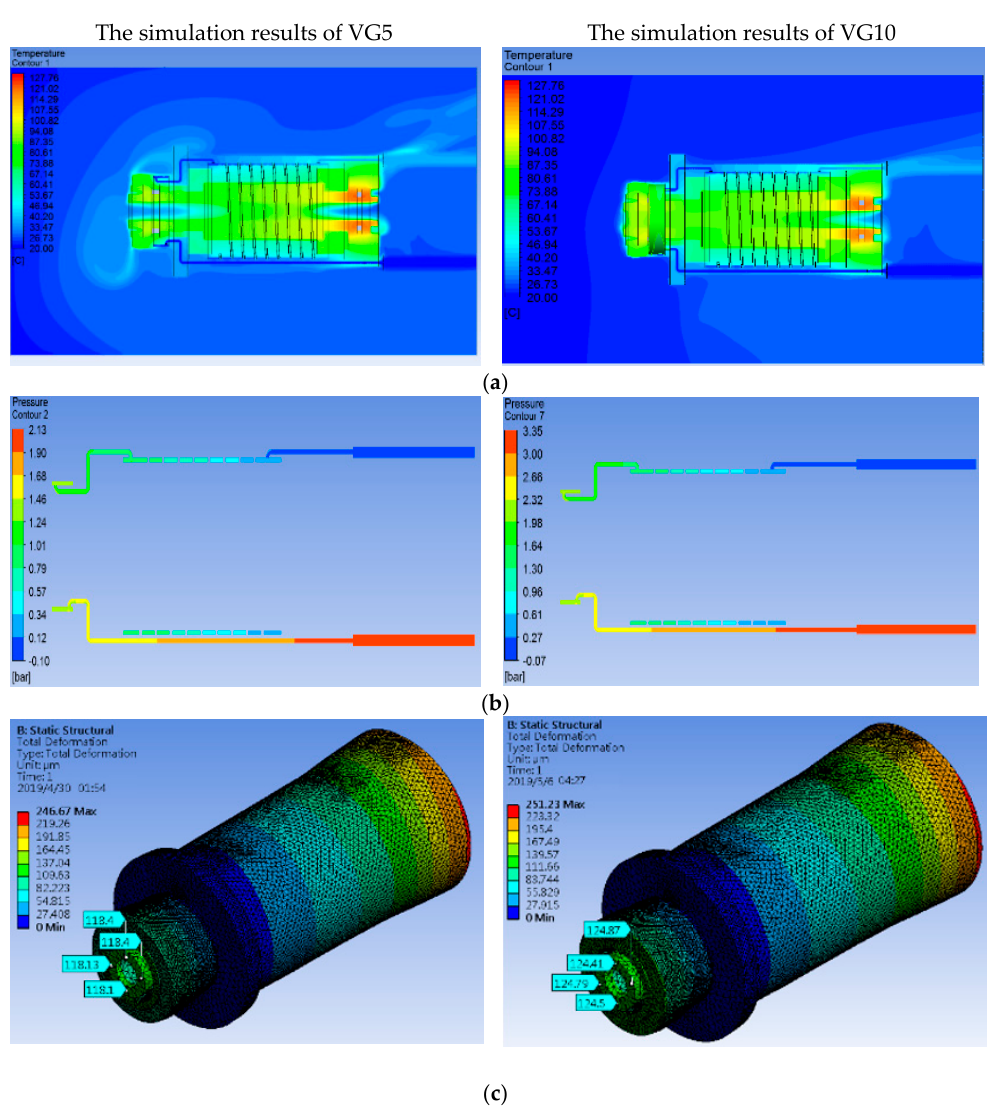
Figure 7. The simulation results of different oil products by ANSYS software. ( a ) Spindle temperature distribution ; ( b ) Channel pressure drop ; ( c ) Spindle deformation.